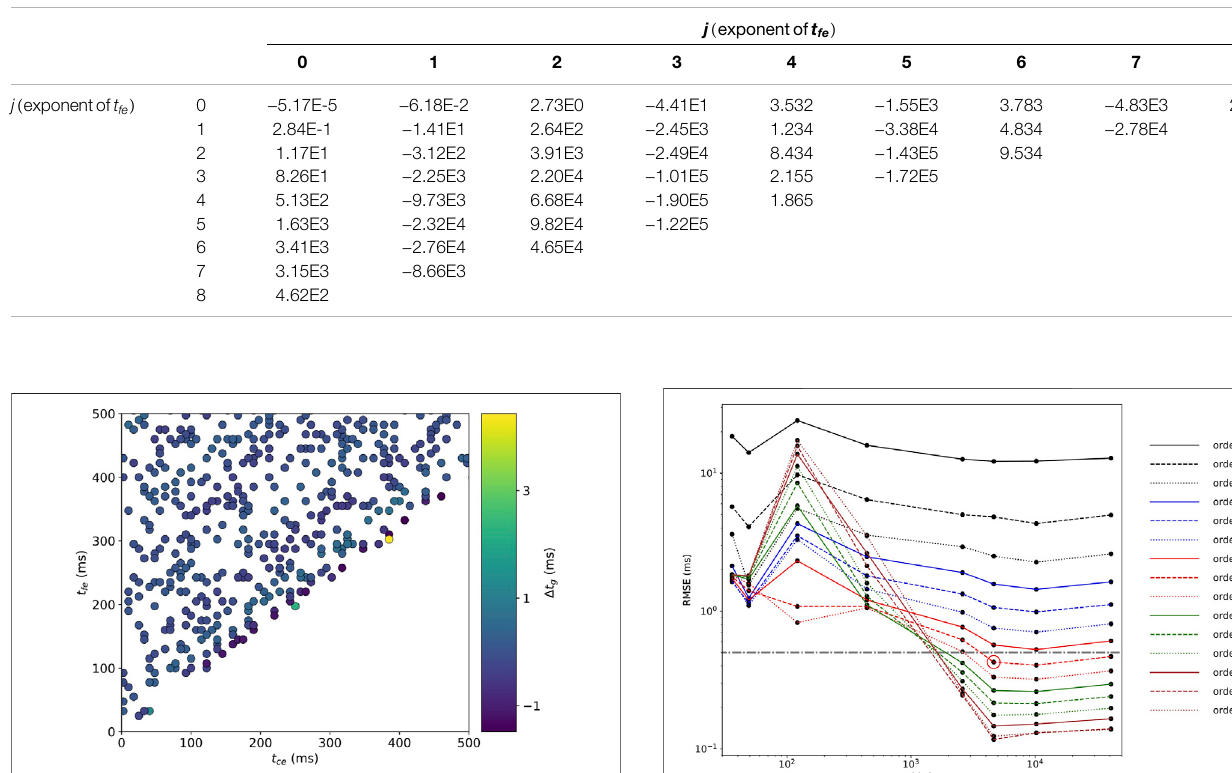
TABLE 1 | Coef fi cients ( α ij , where 0 ≤ i + j ≤ 8) of the eighth-order multivariate polynomial model given by Eq. 3 .